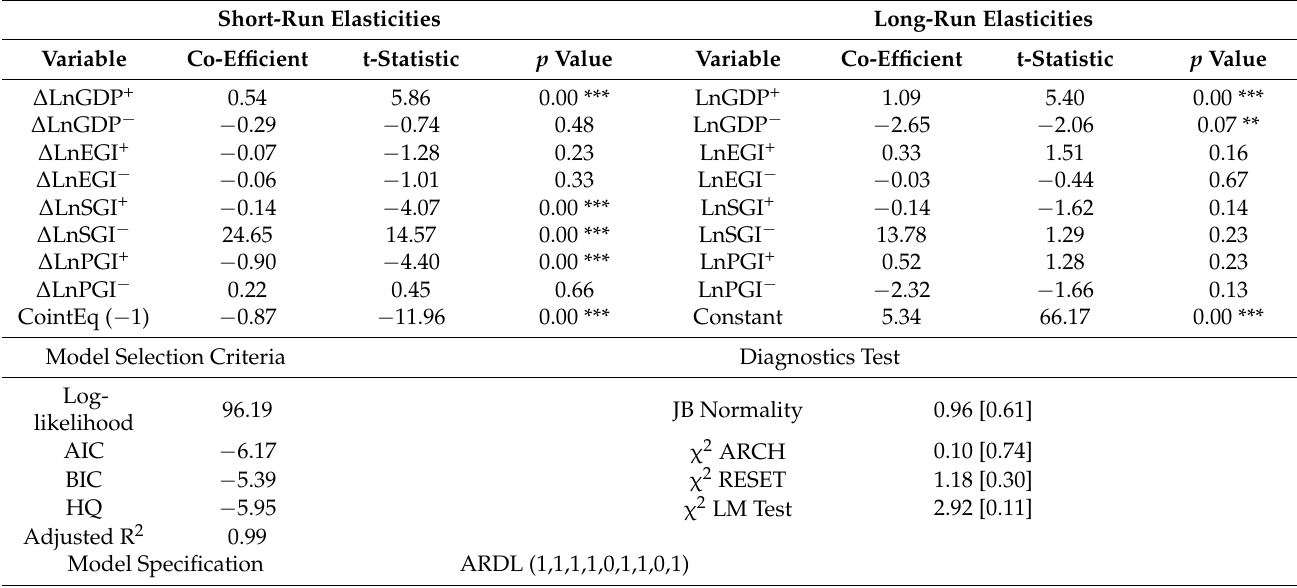
Table 6. Results of asymmetric